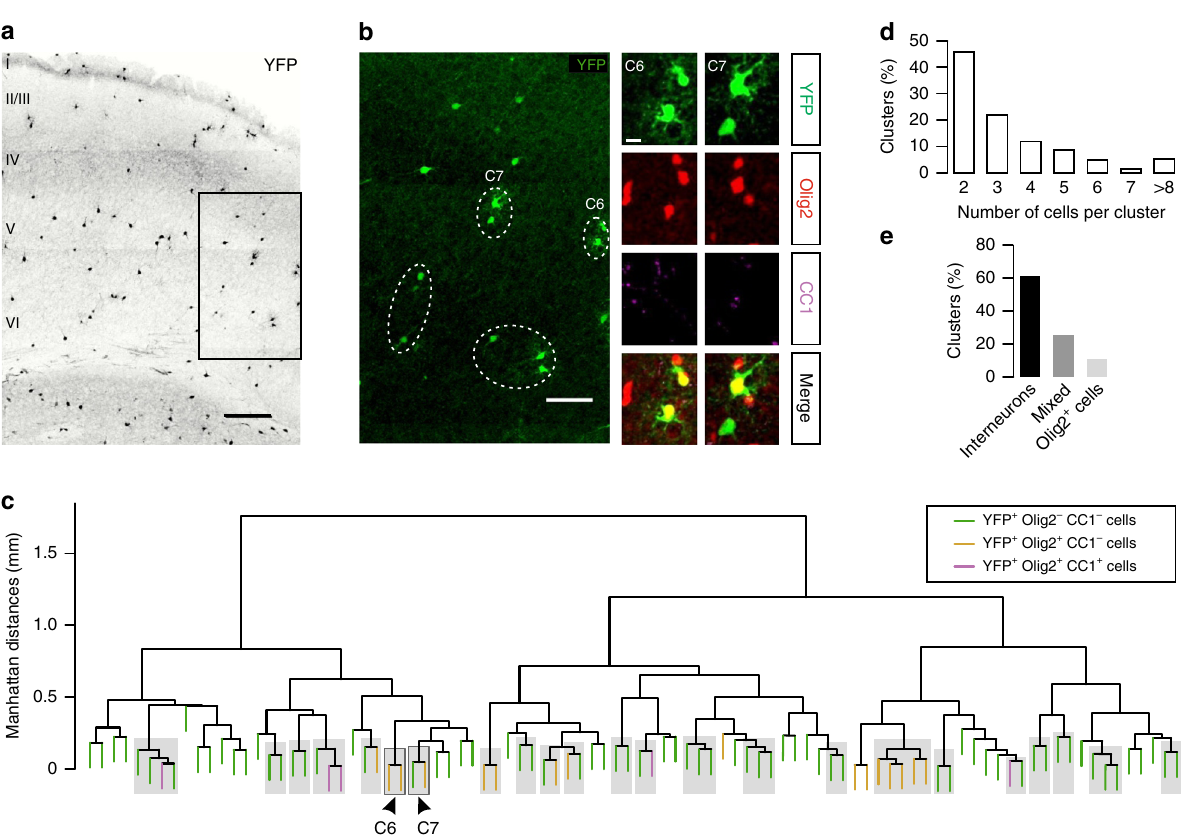
Fig. 2 Dbx1-derived interneurons and OPCs form cell clusters at PN10. a Confocal image of a coronal section of the somatosensory cortex from a PN10 Dbx1 CRE ;Rosa26 YFP mouse showing YFP + cells. Scale bar: 200 µ m. b Magni fi cation of the rectangle in a showing the unsupervised clusters of YFP + cells detected by hierarchical cluster analysis in this region (dotted ellipses). Insets: two identi fi ed clusters containing OPCs and detected with an approximately unbiased p -value ≥ 0.95. They are indicated by arrowheads in the dendrogram in c . Note that C6 is formed by two YFP + /Olig2 + /CC1 − OPCs and C7 by a YFP + interneuron (negative for both Olig2 and CC1) and a YFP + /Olig2 + /CC1 − OPC, showing the co-existence of different cell clusters. Mature YFP + / Olig2 + /CC1 + OLs are rarely observed at this age. Scale bars: 80 and 10 µ m. c Hierarchical clustering dendrogram displaying the relationship between Dbx1-derived interneurons (green), OPCs (yellow) and OLs (magenta) according to their Manhattan distances in the same slice. Detected YFP + cell clusters with approximately unbiased p values ≥ 95% are shown in gray boxes while isolated cells are outside these boxes (72 ± 3% cells in clusters vs. 28 ± 3% isolated cells; n = 11 slices from 4 mice, p < 0.0001, Mann – Whitney U test). d , e Percentages of clusters according to the number of cells per cluster ( d ) and the cell composition ( e